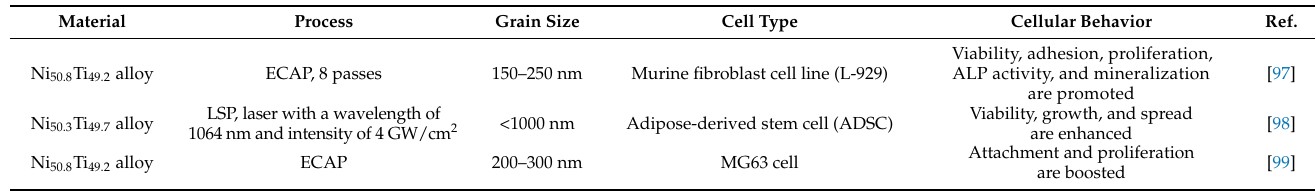
Table 6. Cell response to NiTi shape memory alloys after surface/bulk grain refinement.